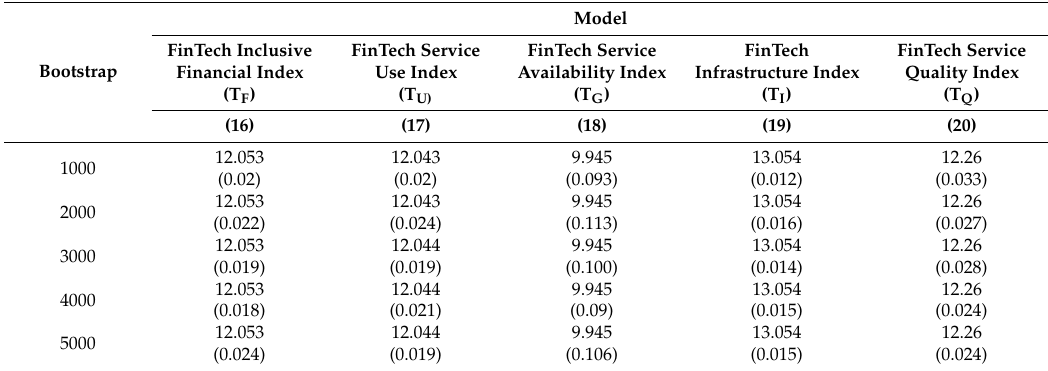
Table 5. LM test based on Bootstrap.